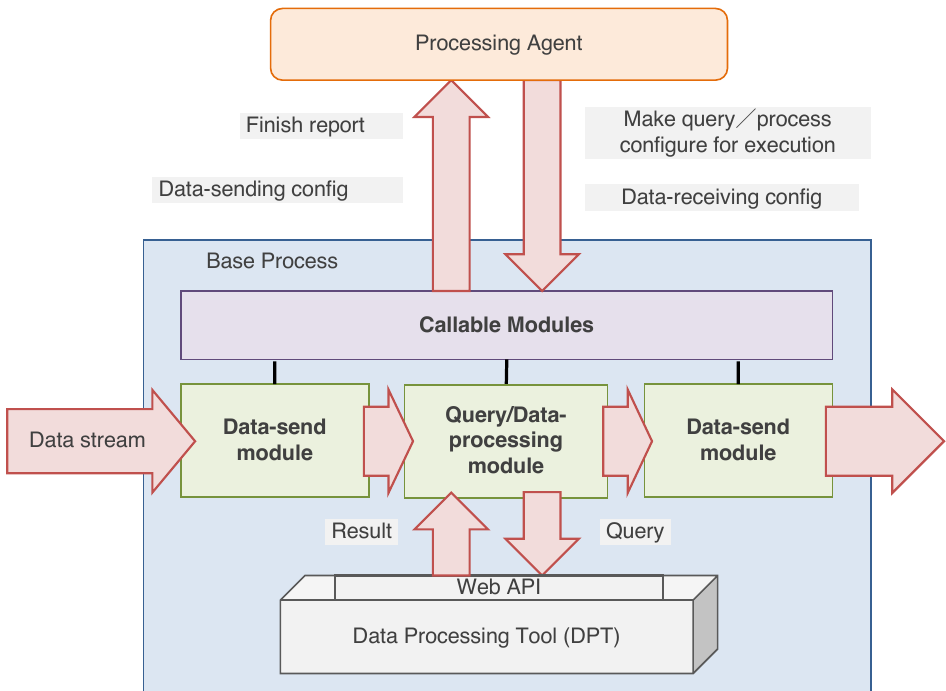
Figure 5. Structure diagram of a base process in a DPA. The blue part represents the base process. The green boxes are modules that transfer data and process them via DPT functions. The purple box represents methods callable from the agent (brain) part.